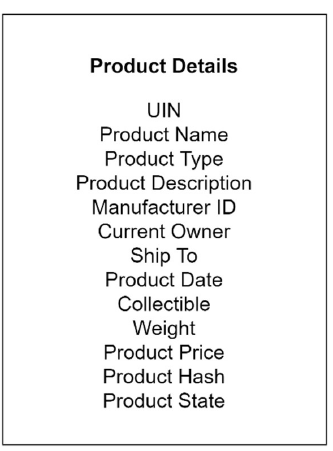
Fig. 5. Item Details stored in Blockchain